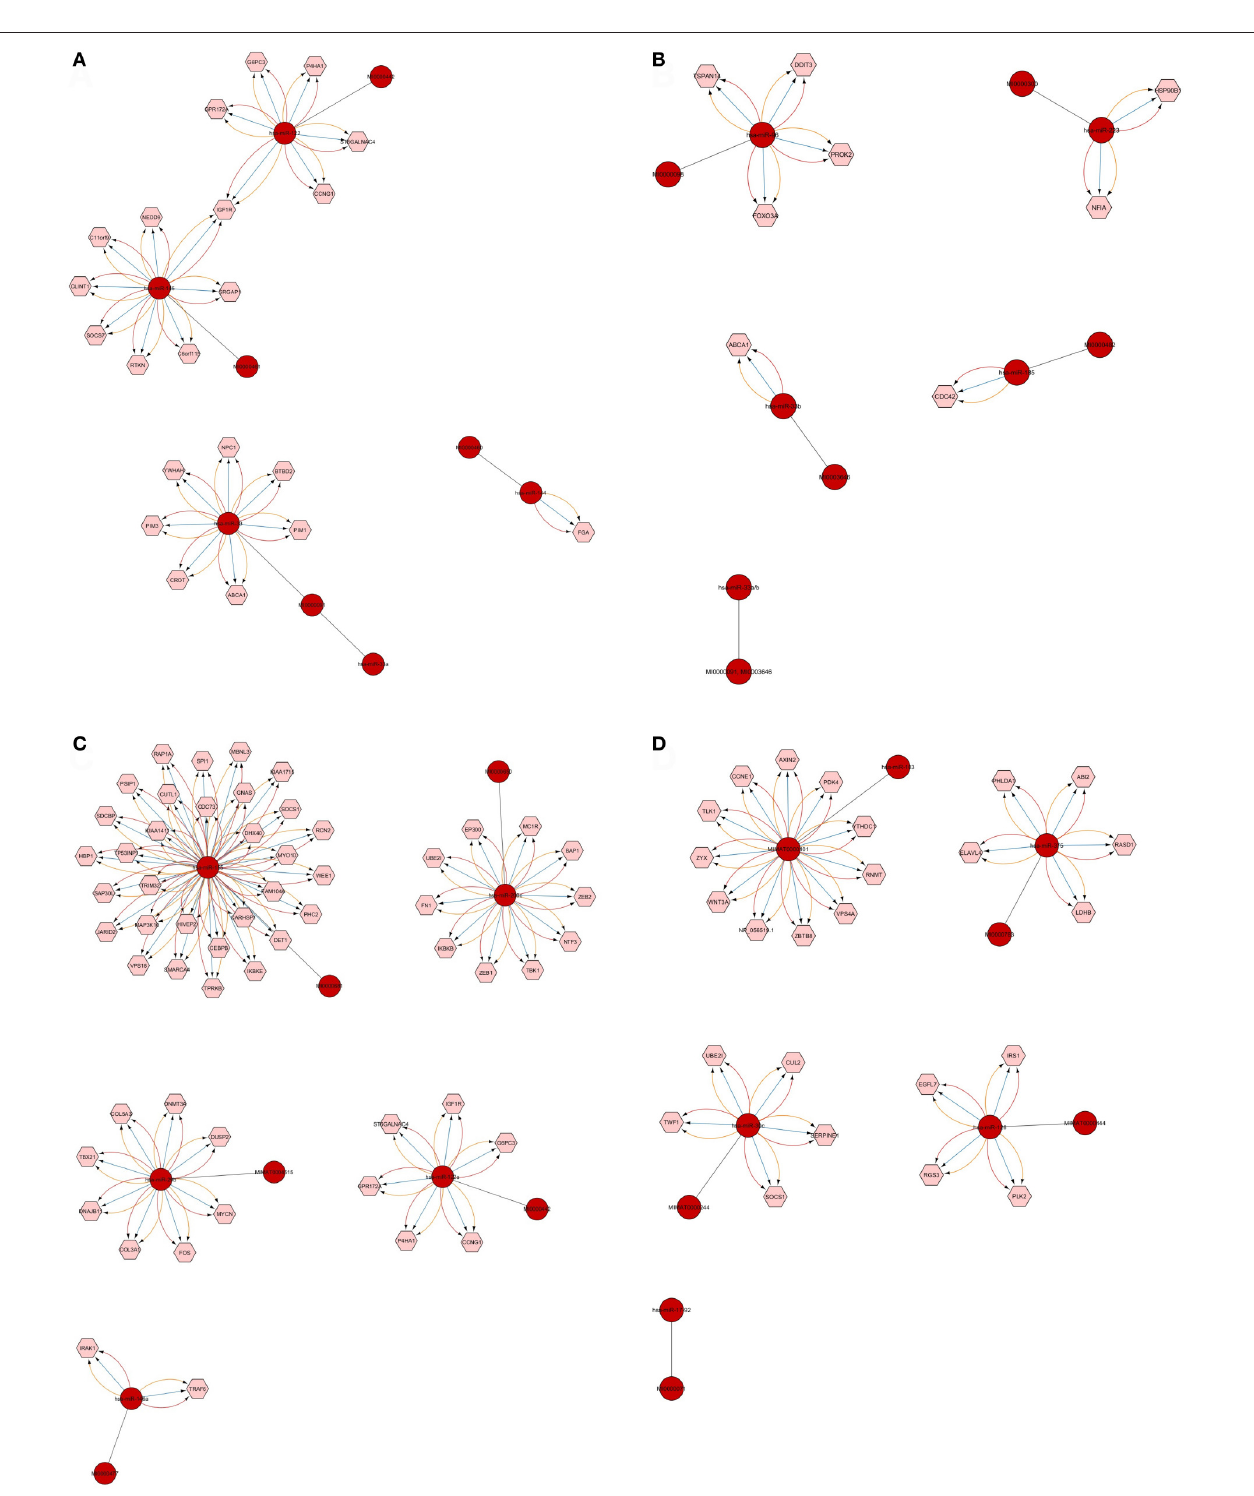
FIGURE 7 | Defined number of predicted and validated target genes from Top 20 significant miRNAs. Among the 20 significant miRNAs, only 18 showed a defined number of targets at threshold 3 functionality modes on CyTargetLinker and Cytoscape. The miRNAs and their accession numbers are in red circles; pink hexagonal shapes indicate their regulatory interaction (targeted mRNAs/genes). The different colors of arrows show regulatory interactions for the identification based on miRNA validated and predicted databases (miRTarBase, MicroCosm, and TargetScan). Each miRNA targets mRNA/genes and the high number of such targets is shown in (C) where miRNA-155 has 31 targets and miRNA-200c has 11. In (D) miRNA-103 has 11 targets. Single targets also were found as shown in (A) for miRNA-144 and (B) for miRNA-33b and miRNA-185.